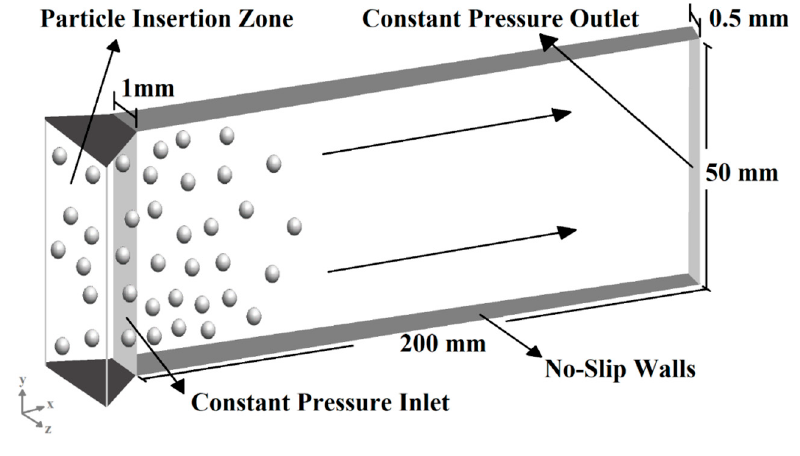
Figure 1. A schematic diagram of the fracture geometry used in the numerical simulation.